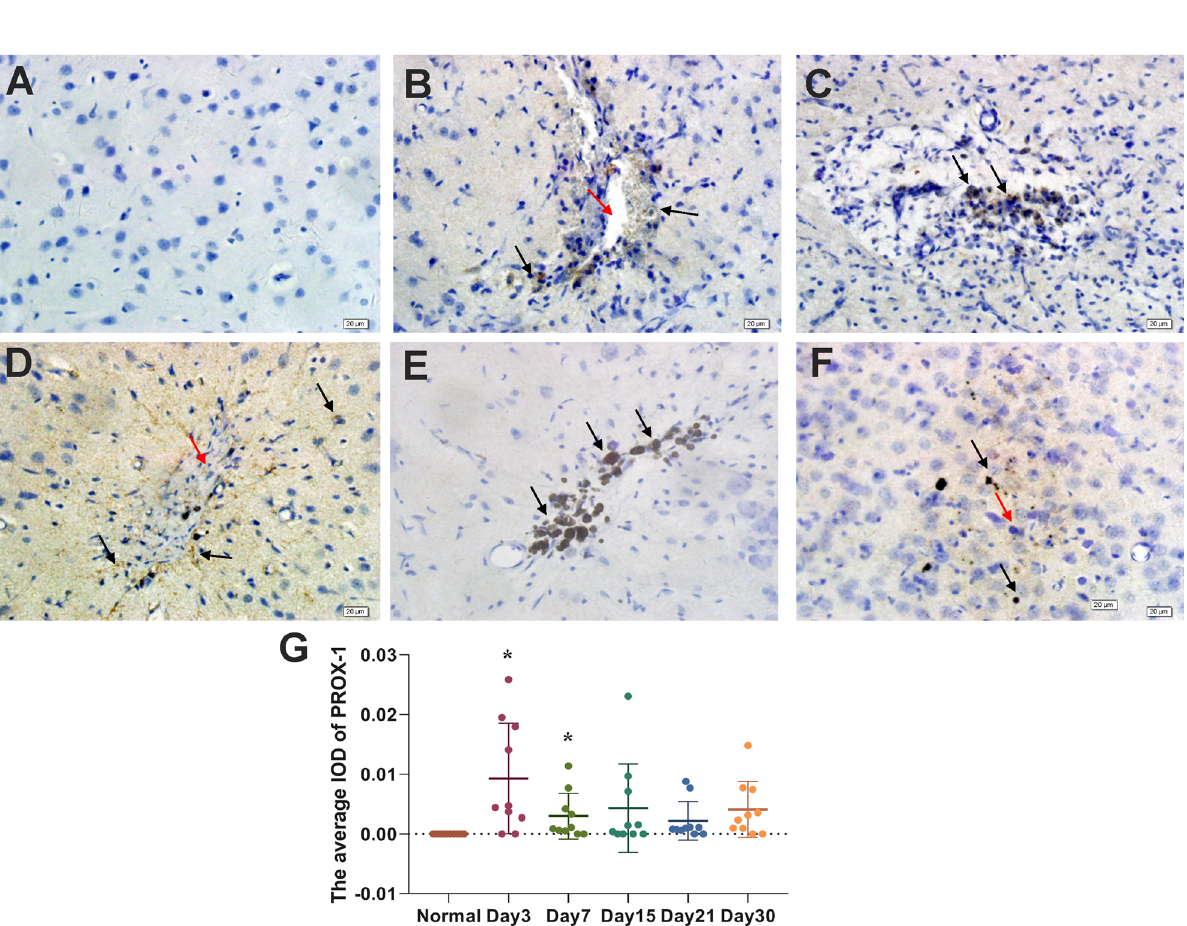
Figure 5. Immunohistochemical staining images showing PROX1 expression in ( A ) normal mouse brain tissue and ( B – F ) mouse brain tissue on days 3, 7, 15, 21 and 30 days, following pTBI. ( A ) PROX1 is not expressed in normal mouse brain tissue. PROX1 expression (brown; black arrows) was detected around the injury site (red arrow) on days ( B ) 3 and ( C ) 7. ( D ) PROX1-expressing cells and tubular structures (black arrows) were observed around the injury site on day 15 and a small number of black hemosiderin particles (black arrowheads) were visible. ( E , F ) PROX1 expression (black arrows) and black hemosiderin particles (black arrowheads) were still visible at the injury site on days 21 and 30. ( G ) Immunohistochemical results of PROX1 were analyzed by Image-Pro Plus 6.0 software. The average density (IOD) of PROX1-positive cells in normal mouse brain tissue and in mouse brain tissue on days 3, 7, 15, 21 and 30 days, respectively, following pTBI. The n = 10/group was used for calculating the average IOD. Comparisons between groups were performed using the Kruskal–Wallis H test followed by Bonferroni post-hoc